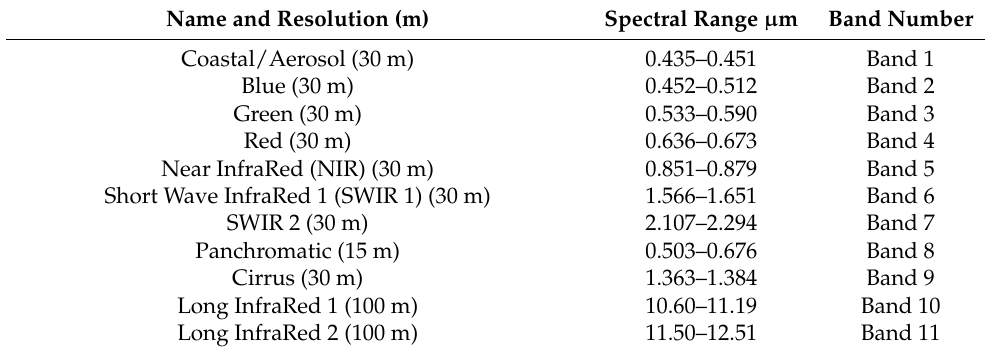
Table 1. OLI and TIRS bands description, information gathered from [21]. The visible part of the electromagnetic spectrum is covered by bands 1–4 and 8 with a ground resolution of 30 m, except for bands 8 that has a resolution of 15 m. The NIR is covered by band 5 with a resolution of 30 m. The SWIR is covered by bands 6 and 7 with a resolution of 30 m. The thermal bands 10 and 11 have a resolution of 100 m on the ground. Name and Resolution